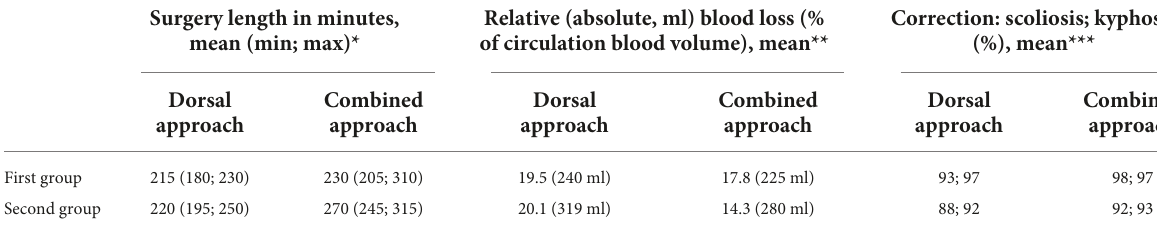
TABLE 3 Characteristics of surgical treatment parameters depending on surgical access in children of different age groups.